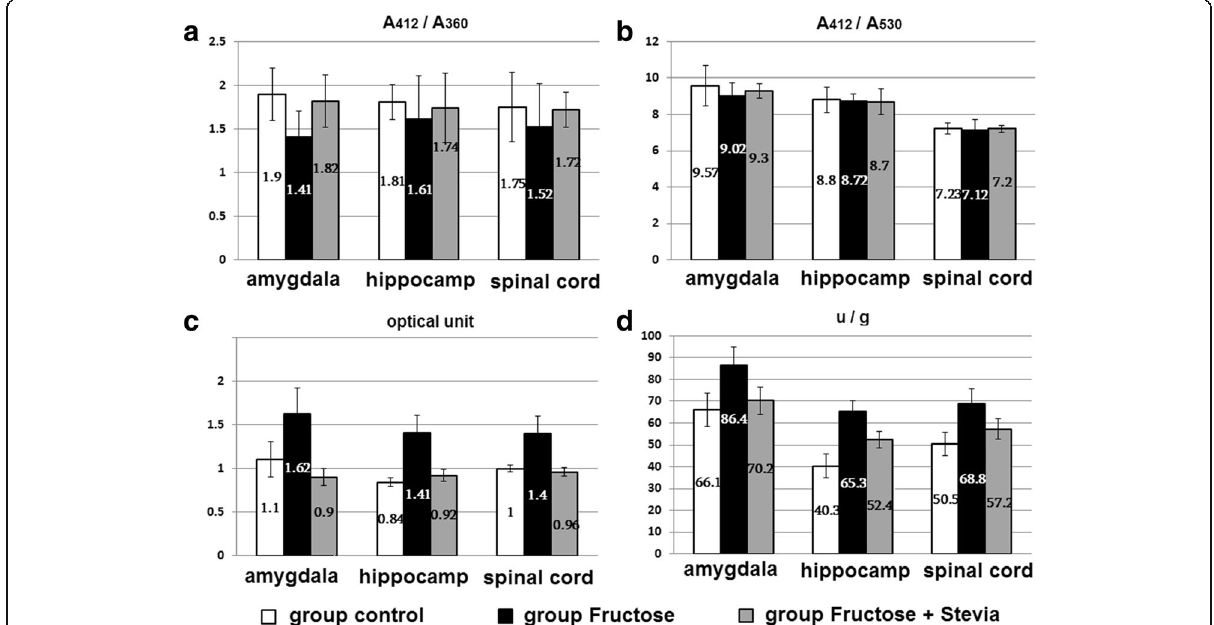
Fig. 3 Optical spectral absorbance indices of A 412 /A 360 ( a ) and A 412 /A 530 ( b ) of total fraction of Nox isoforms, isolated from the amygdala, hippocampus and spinal cord of rats of these groups (M ± m; n = 6; p < 0,05). ( c ) - relative optical absorbance of total fractions of Nox isoforms from the amygdala, hippocampus, spinal cord (per optical units), and ( d ) – calculated ratio/proportion of the NADPH- dependent O 2 − − producing activity of total fraction of Nox isoforms (U/g tissue) in these groups (M ± m; n = 6; p <